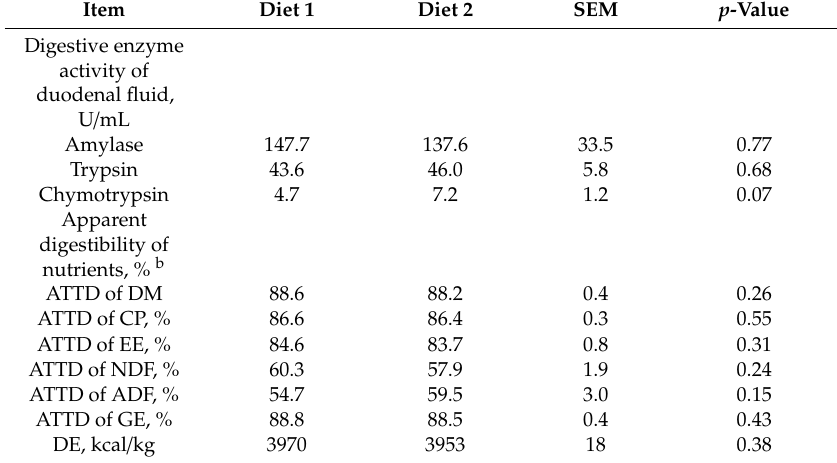
Table 4. E ff ect of dietary particle size on the digestive enzyme activities in duodenal fluid and digestibility of dietary nutrients in pigs (DM basis) a .